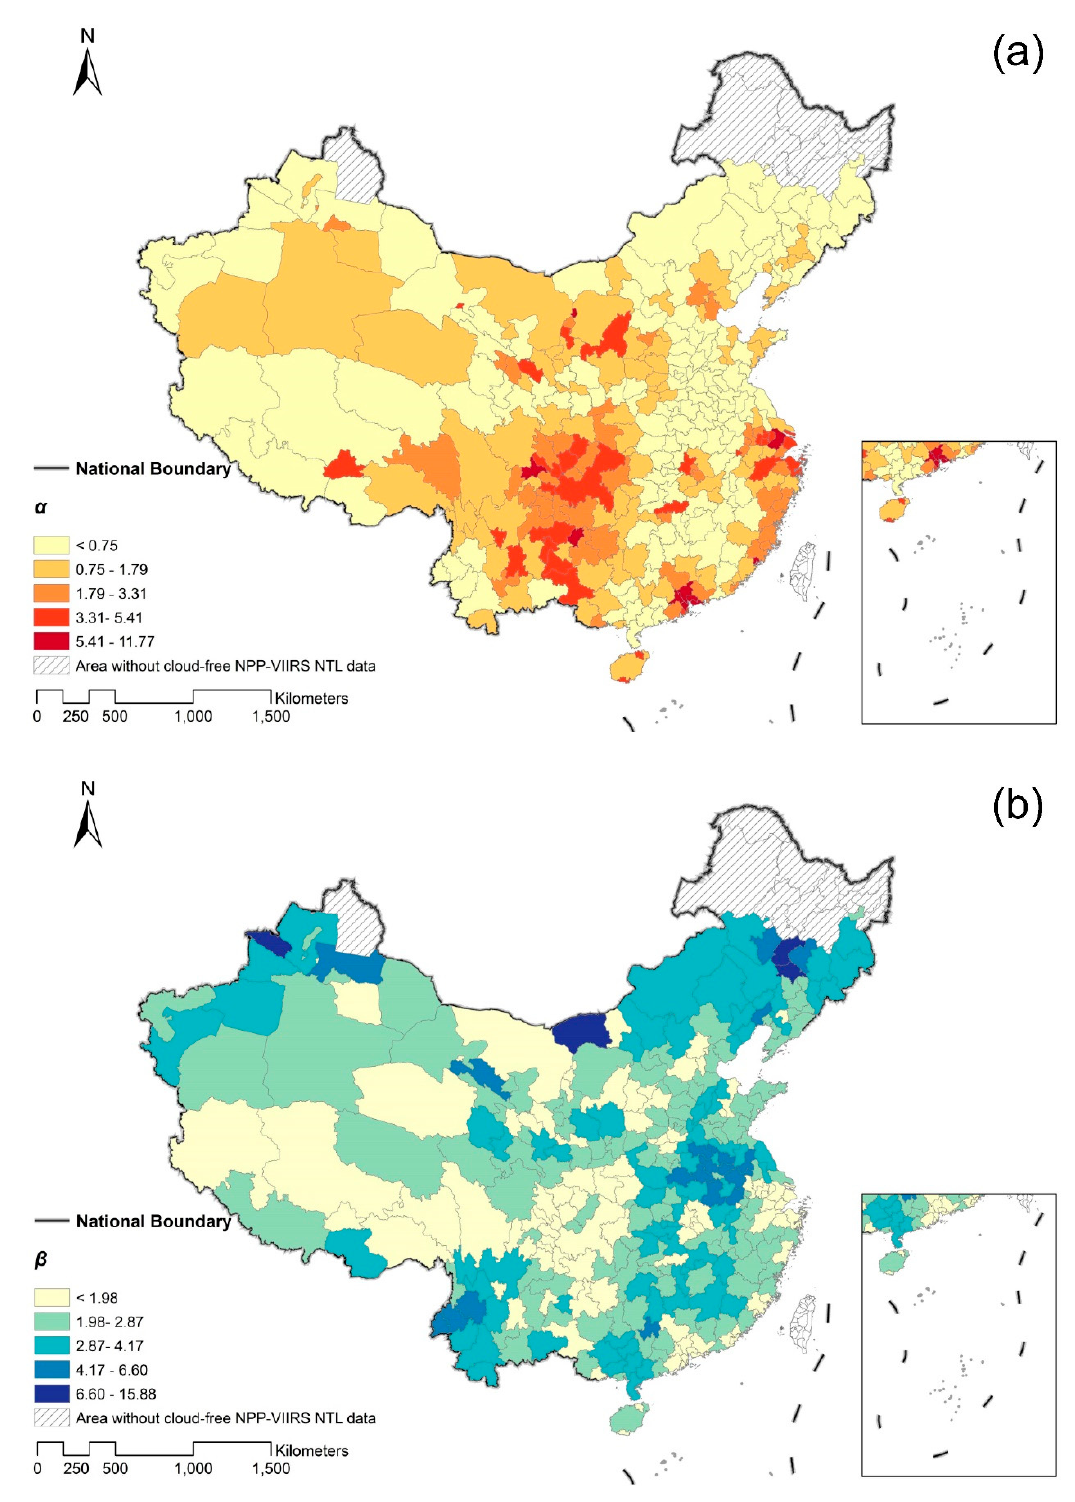
Figure 7. Spatial distribution of ( a ) coefficient α and ( b ) coefficient β in Mainland China.